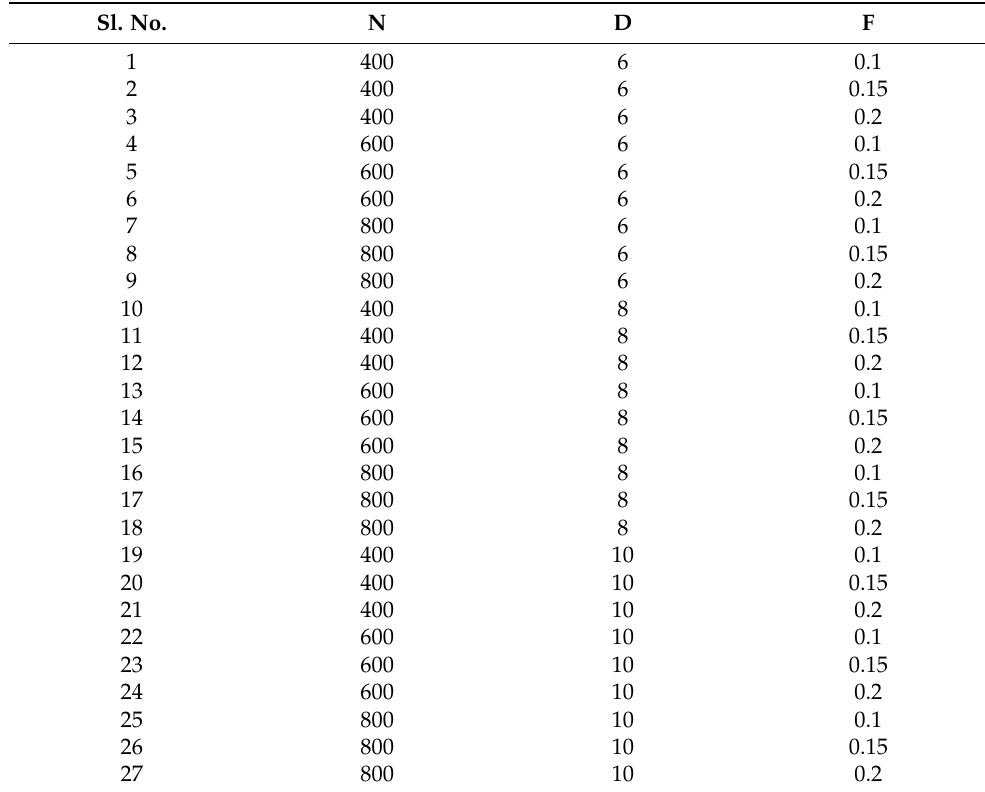
Table 2. Experimental design using L27 orthogonal Table 1. Factors and their level combination for drilling.